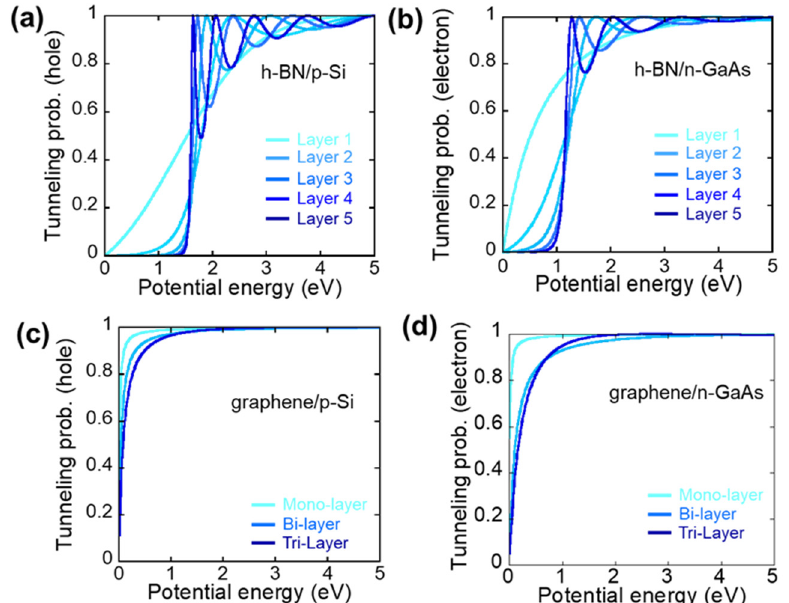
Figure 4. Tunneling probability of ( a ) a hole and ( b ) an electron across h-BN/p-Si and h-BN/n- GaAs with different h-BN thicknesses, and ( c ) a hole and ( d ) an electron across graphene/p-Si and gra-phene/n-GaAs with different graphene thicknesses.